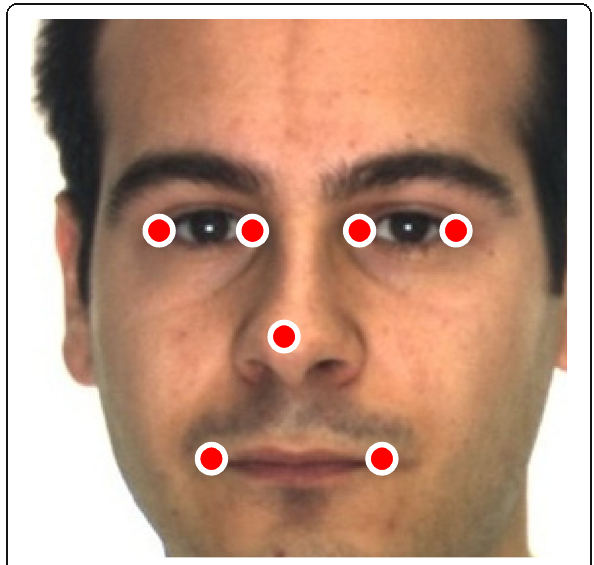
Fig. 6 Seven selected key landmarks for face alignment